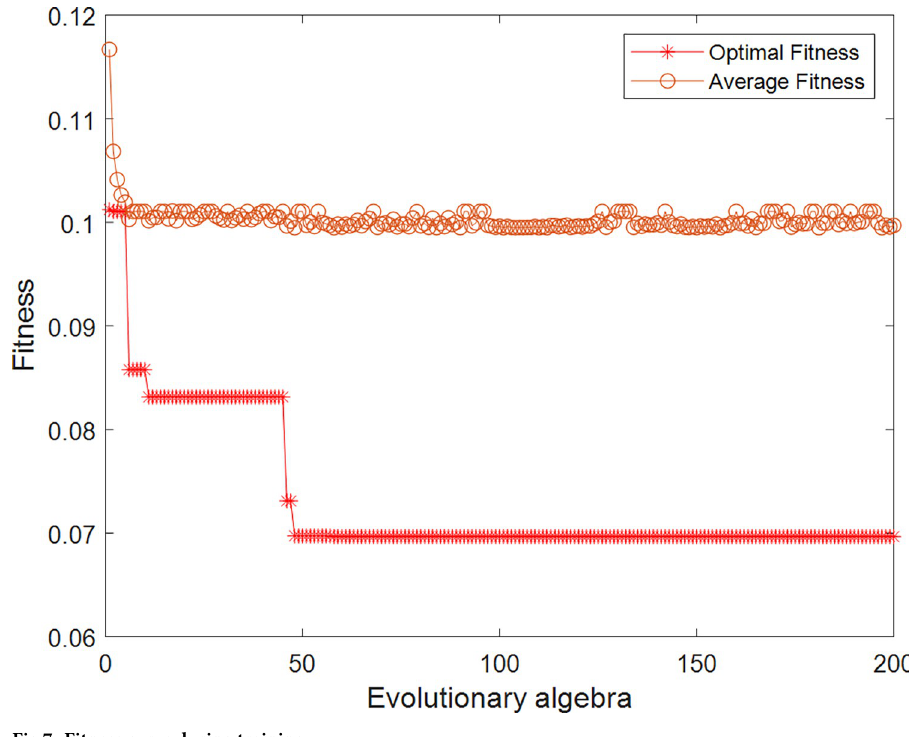
Fig 7. Fitness curve during